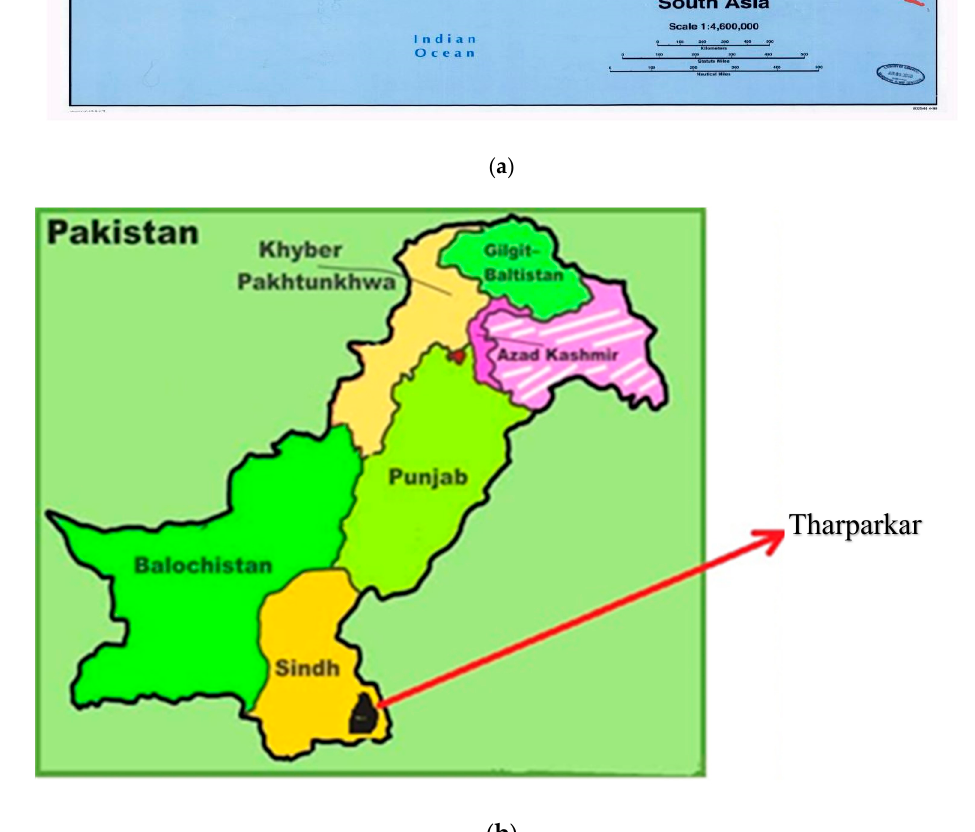
Figure 1. ( a ) Location of Pakistan in South Asia; ( b ) location of Tharparkar district in Pakistan. Both are highlighted with an arrow.